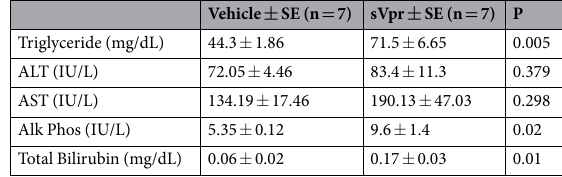
Table 2. Plasma triglycerides and liver functions in sVpr- and vehicle-treated mice.